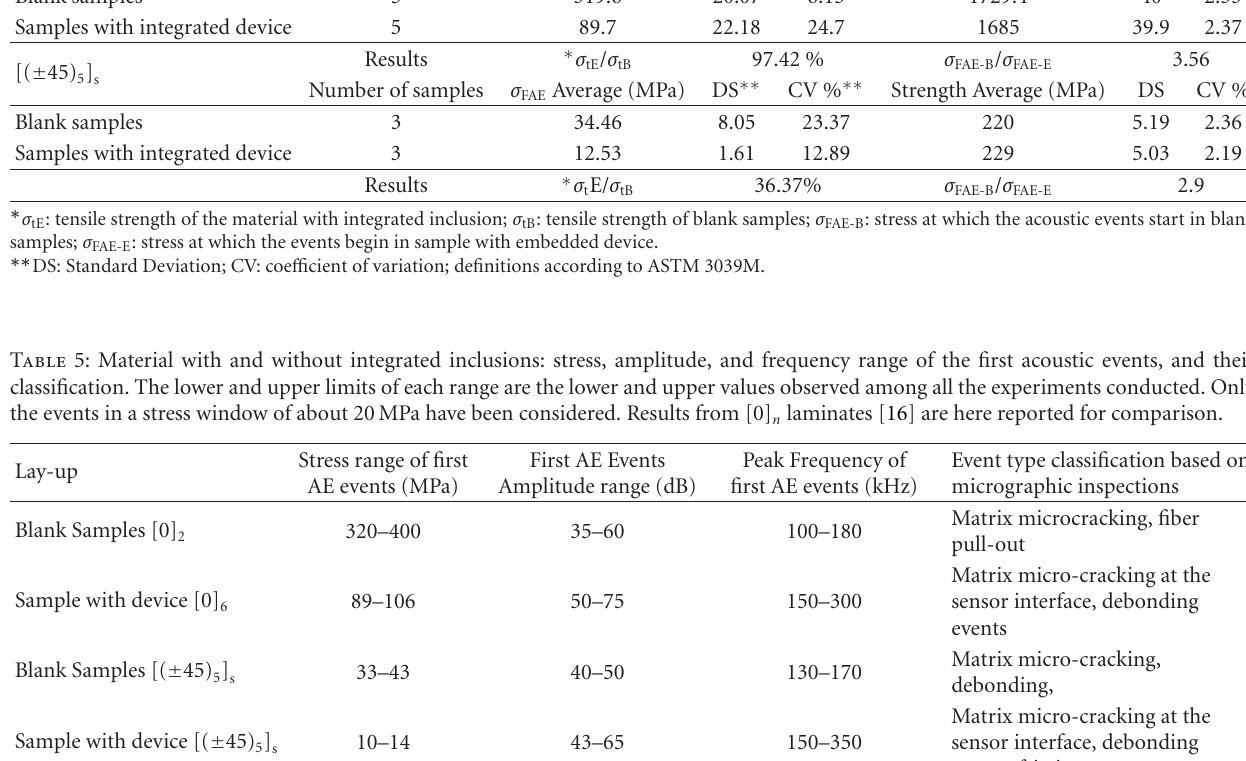
Table 4: Material without and with embedded inclusions: tensile strength and acoustic behavior.